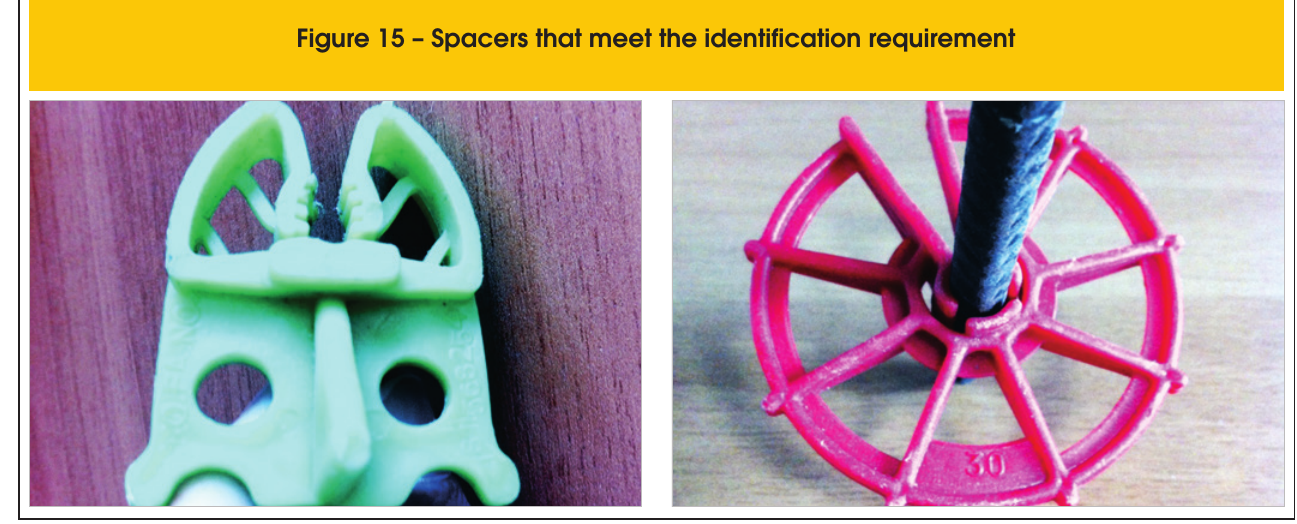
Figure 15 – Spacers that meet the identification